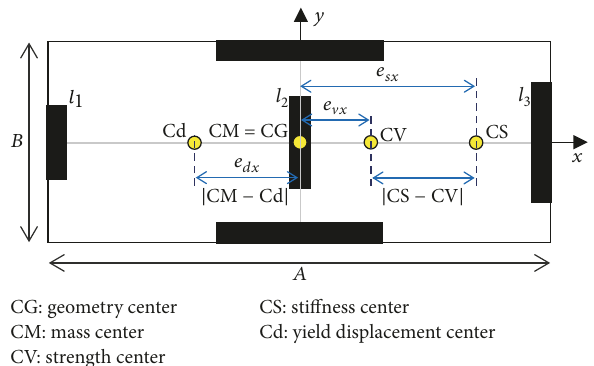
Figure 1: Centers of structural model and their eccentricities.